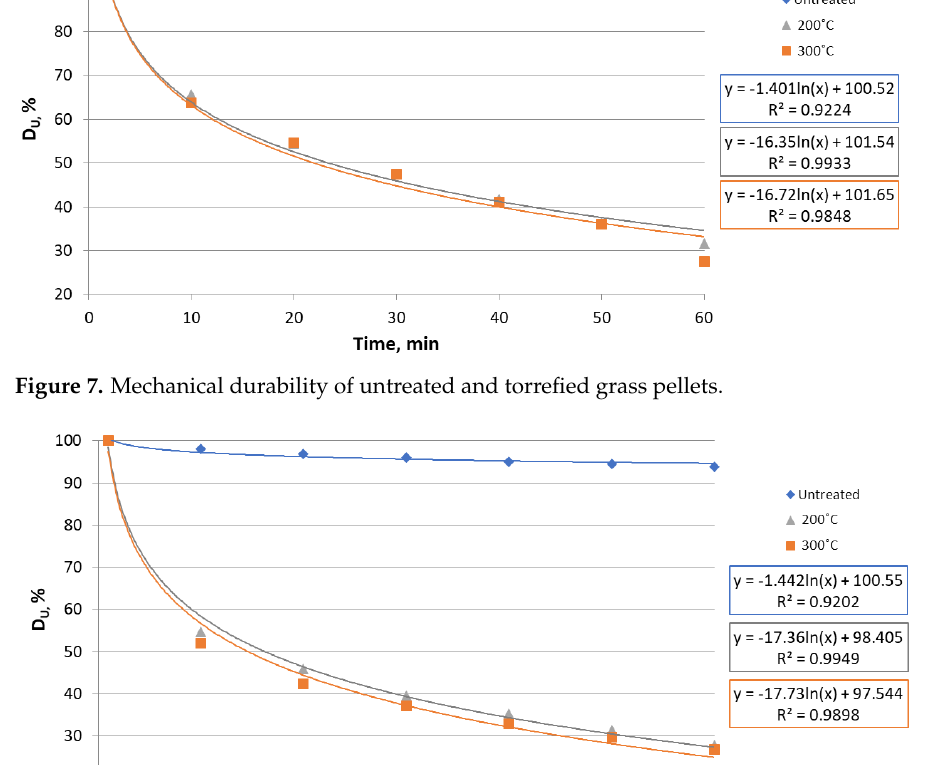
Figure 9. Mechanical durability of untreated and torrefied wheat straw pellets. Furthermore, the result indicated that the torrefaction temperature did not affect the mechanical durability index D U during the longer operation time of the working cham- ber. For the temperatures examined (200 °C and 300 °C), the values of the D U index were very similar (Figures 5 – 9). For example, the mechanical durability index of wheat straw pellets was D U = 27.24% ± 1.61% (at 200 °C) and D U = 28.03% ± 2.61% (at 300 °C). It is also confirmed by the statistical analysis performed using ANOVA and post hoc tests (Table 3). In the case of sunflower husk, beetroot pomace, and pine tree pellets, there were no significant differences between pellets torrefied at 200 and 300 °C ( p -value > 0.05). It can be concluded that applying a treatment temperature greater than 200 °C will not affect significantly the mechanical durability. Only in the case of grass and wheat straw pellets, in all time variants, were the values statistically different ( p -value < 0.05). Table 3. Statistical results of the ANOVA and post hoc Tukey test of the influence of torrefaction temperature on the mechanical durability for an operation time of 60 min. Temperature